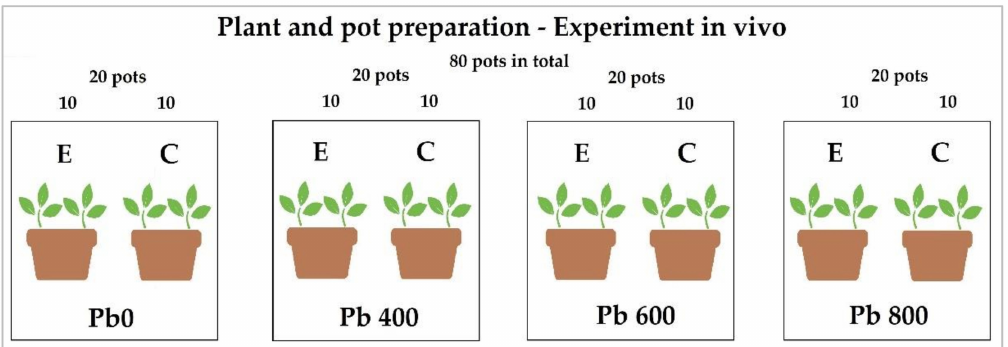
Figure 1. Design of the in vivo experiment. Galena at each concentration was added separately to the soil and well mixed before dividing into 20 pots for each treatment for a total of 80 pots. In each pot, two seeds of Festuca arundinacea were sown. Pots labelled E were treated with the endophyte consortium and those labeled C were treated with sterile